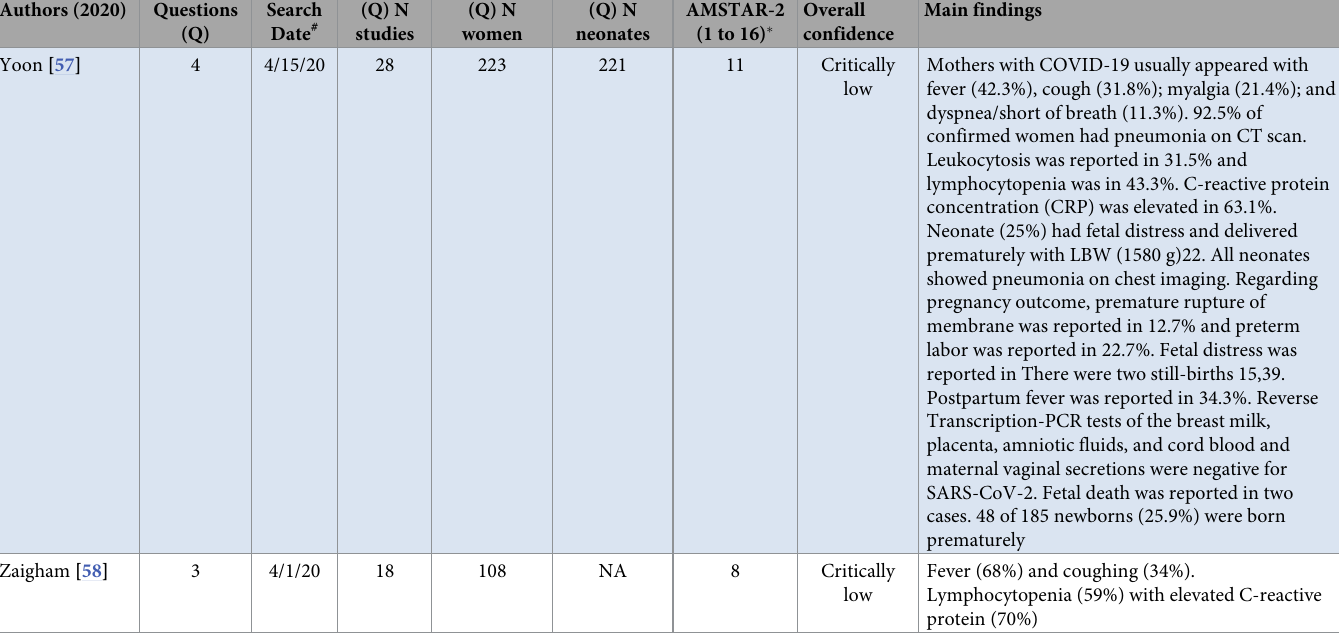
4%, and required invasive ventilation was